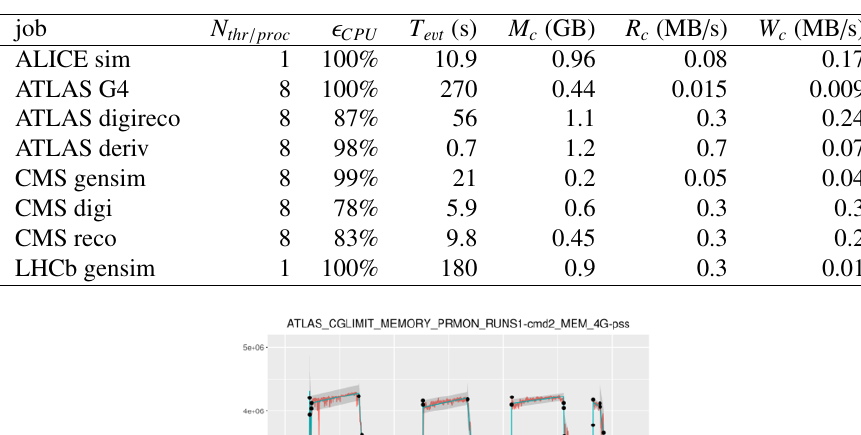
Table 1. Metrics measured by PrMon on a set of reference workloads with an Intel Xeon E5-2630. Values are approximate and may change with di ff erent versions of the experiment software